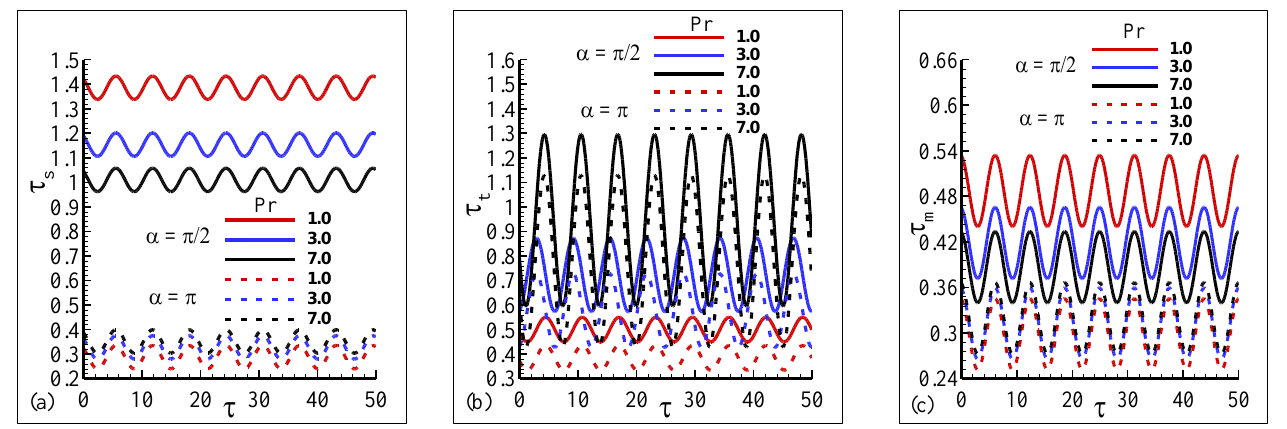
Figure 5. The geometrical plots of ( a ) 𝜏 𝑠 ( b ) 𝜏 𝑡 , and ( c ) 𝜏 𝑚 at 𝜋 2⁄ and 𝜋 positions with two values of reduced gravity Rg = 0.1,0.3 and 0.5 with some fixed 𝛾 = 0.1 , 𝜉 = 0.3 , Pr = 7.0 , and 𝜆 = 1.1 .